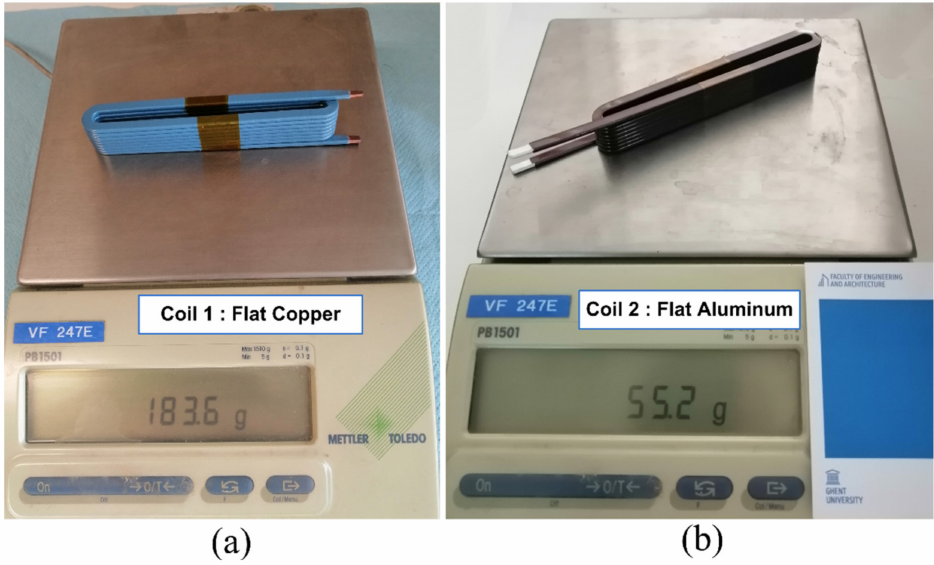
Figure 6. Copper and aluminum test samples and weight comparison.